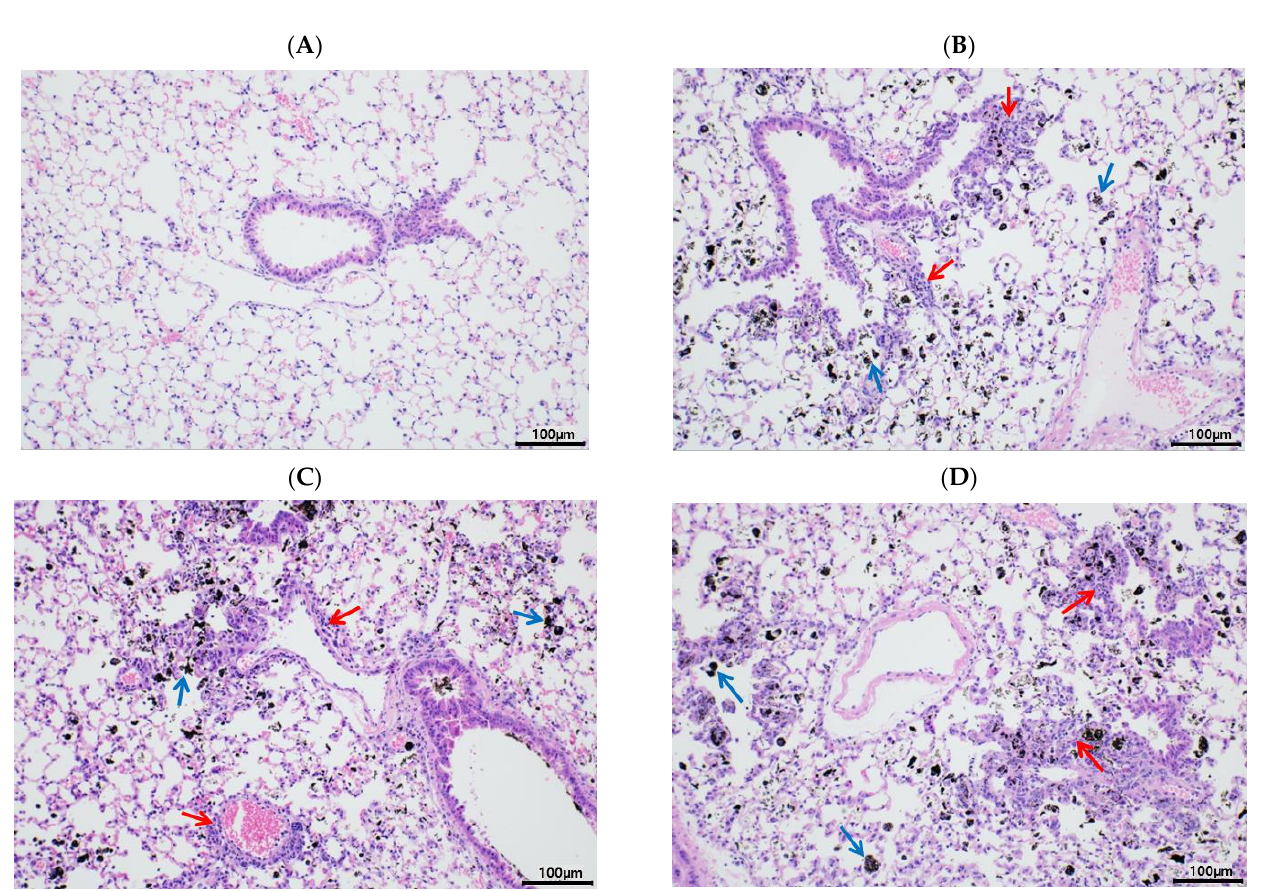
Figure 2. Histological changes in lung tissue after ellagic acid (EA) pretreatment and particulate matter (PM) instillation. C57BL/6 mice were orally pretreated with ellagic acid (EL; 20 mg/kg or EH; 100 mg/kg) for 7 days, and then PM (5 mg/kg) was intratracheally administrated for 7 days with or without ellagic acid pretreatment. Representative images of hematoxylin and eosin (H&E) stained sections obtained from the ( A ) CON, ( B ) PMI, ( C ) EL + PMI, and ( D ) EH + PMI groups ( n = 8). Blue arrows indicate black-pigment-laden macrophages in the alveoli and alveolar lumen interstitium. Red arrows point to the infiltrated inflammatory cells in the peribronchiolar, perivascular, and interstitial regions. Scale bars = 100 μ m.